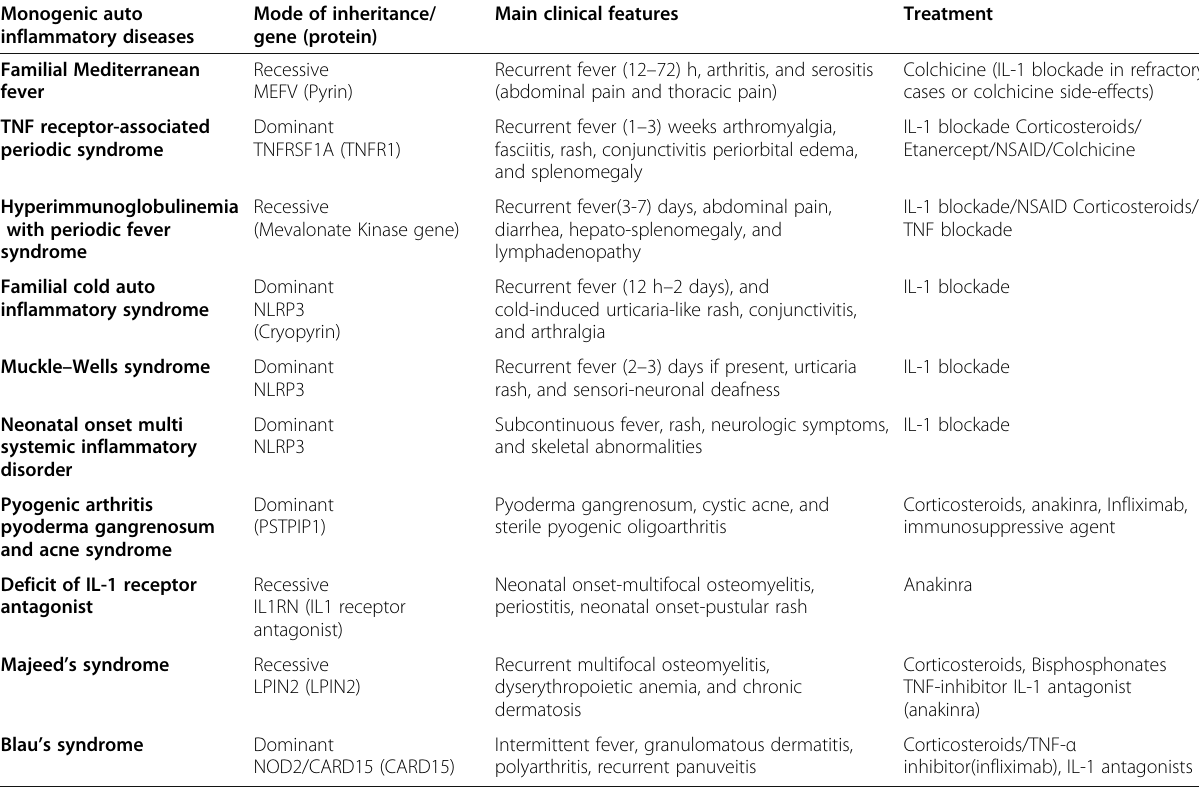
Table 1 Summary of monogenic autoinflammatory diseases [7] Monogenic auto inflammatory